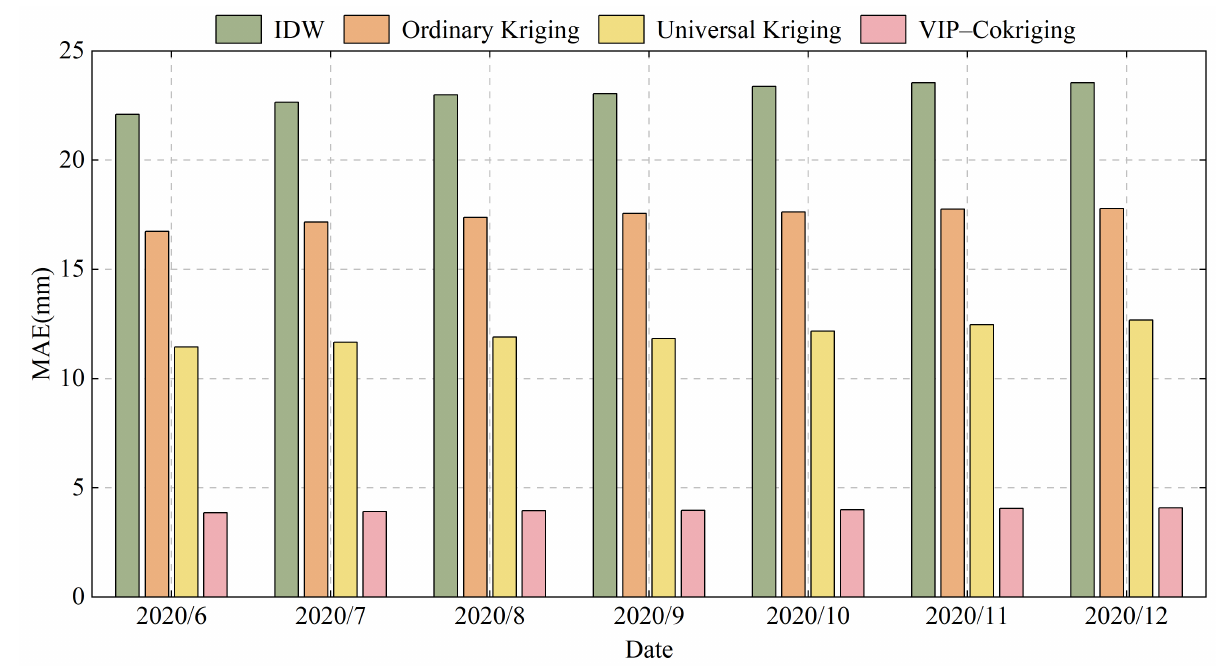
Figure 10. Comparison of MAE of different models. Overall, the VIP–cokriging model had the highest accuracy. The relative error of non–edge measuring points was mostly controlled within 3%, and the relative error of the edge measuring points was reduced compared with the other three models. Its mean absolute error was 3.85 to 4.08 mm, which was 83%, 77%, and 67% lower than that of the inverse distance weighting model, the ordinary kriging model, and the universal kriging model. The main reason was that cokriging introduced one or more auxiliary environ- mental variables that had a strong correlation with the effect variables, and using the cross–correlation between them could effectively improve the spatial expansion accuracy of the main variable at the unknown points, which could solve the problem of the insuf- ficient number of measuring points. 5. Engineering Application The PBG gravel soil earth core wall rockfill dam with a maximum height of 186 m was completed and stored in water for power generation in 2009. Its internal vertical displacement was monitored by the hydraulic overflow settlement gauge, and the measuring points of the typical profile (profile 0+240 m) were arranged, as shown in Figure 11. Due to the impact of temporary dam top removal and permanent dam top construction in 2012, there were many missing measurements between 2012 and 2013. Since completing the automation transformation in August 2013, the continuity of measured values was good. However, there were still some phenomena such as unstable measured values at some measuring points and blockage of instrument pipelines. For example, the CH10 and CH13 at the elevation of 725 m were damaged and measuring stopped in 2015. The stability of the CH14 measured value was poor, with an anomalous steep step from July 2013 to July 2014. At present, the measured value is close to the measuring range of the instrument, and the reliability of the measured value is poor, as shown in Figure 12.